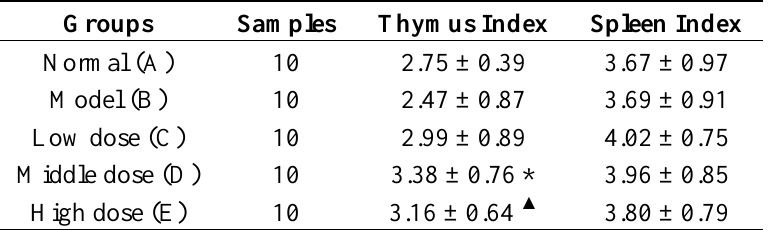
Table 5. Effects of Fuzhuan brick-tea extract on thymus and spleen indices ( x ± s).